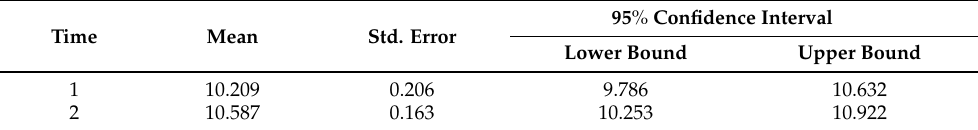
Table 5. Estimates for